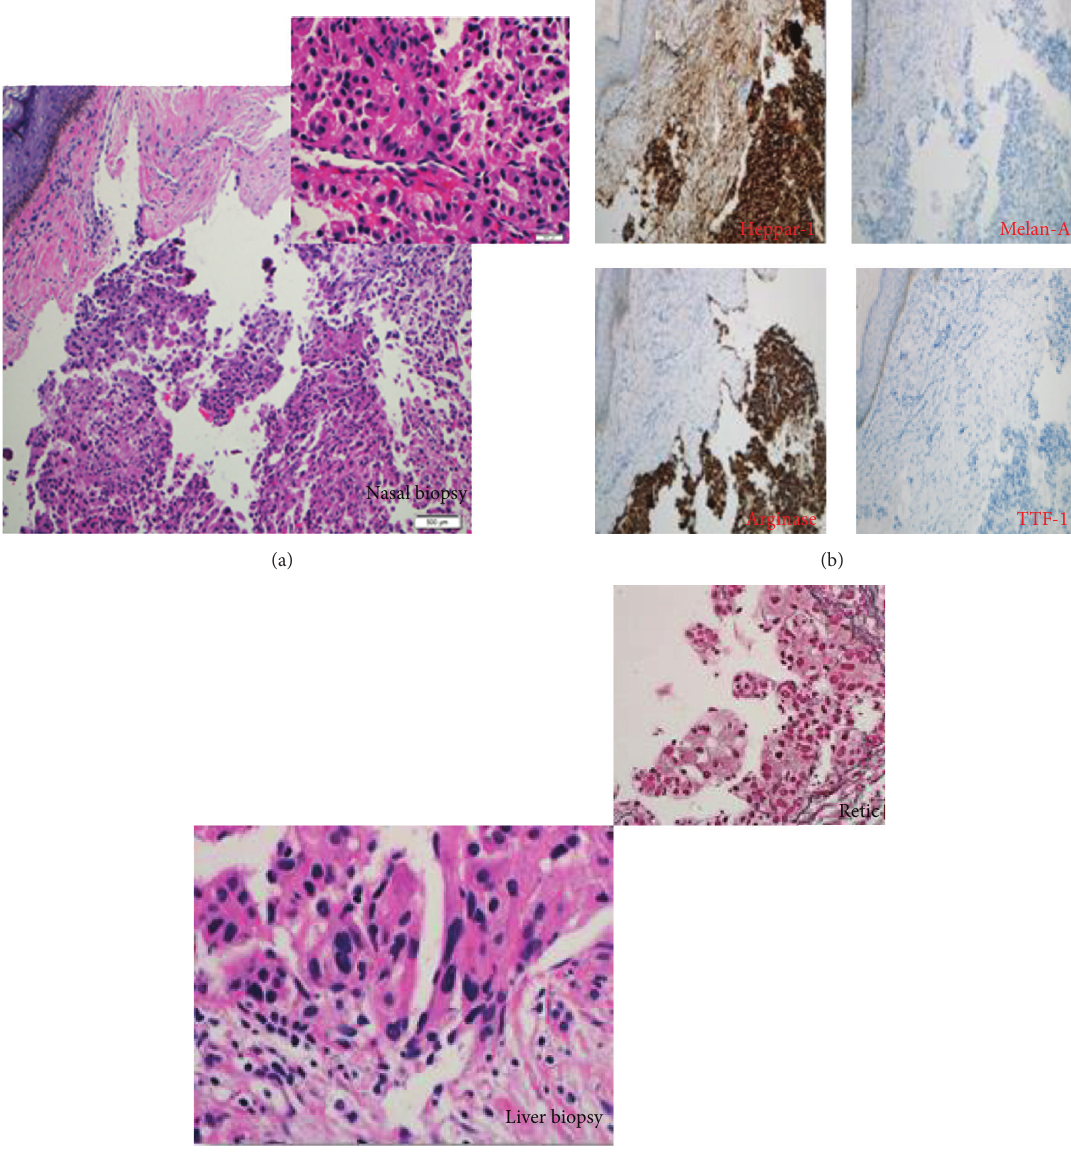
Figure 2: Histopathological studies. (a) H&E staining showing sheets and nests of cells divided by delicate capillaries network. Cytologically, the cells are polygonal with pink cytoplasm and markedly pleomorphic nuclei. (b) Immunohistochemistry: the tumor cells are strongly and diffusely positive with HepPar1, arginase, CD10, and pancytokeratin. Stains with TTF-1, S100, Melan-A, CK7, CK20, P63, synaptophysin, Vimentin, inhibin, PSA, RCC, CK19, and alpha-1-fetoprotein. (c) Liver biopsy reveals large atypical hepatocytes with somehow papillaroid configuration and exhibits marked nuclear pleomorphism and nuclear